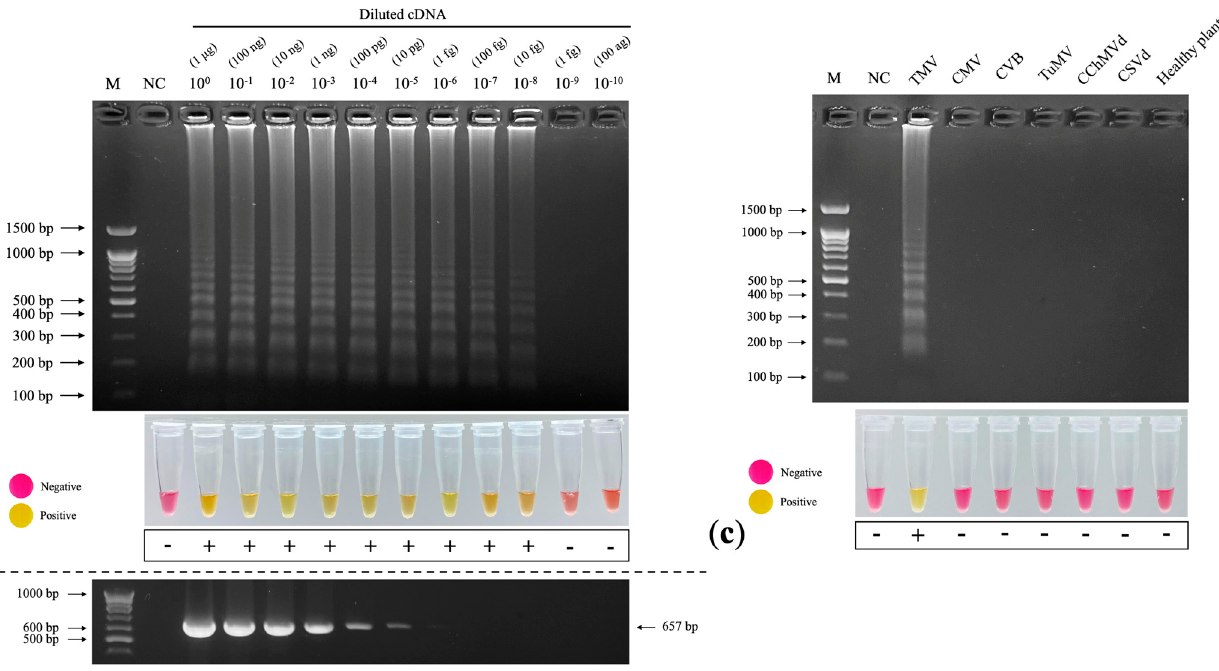
Figure 6. Sensitivity and specificity assays of RT–LAMP TMV detection. ( a ) Limit of detection (LOD) of RT–LAMP–AGE (top) and colorimetric RT–LAMP (bottom) at 10 − 8 diluted cDNA. ( b ) LOD of RT–PCR at 10 − 5 diluted cDNA. ( c ) Specificity test of colorimetric RT–LAMP for TMV detection, showing a ladder-like pattern of LAMP products in only the TMV lane. M: 100 bp + 1.5 kb DNA ladder (SibEnzyme, Novosibirsk, Russia); NC: negative control (nuclease-free water) .